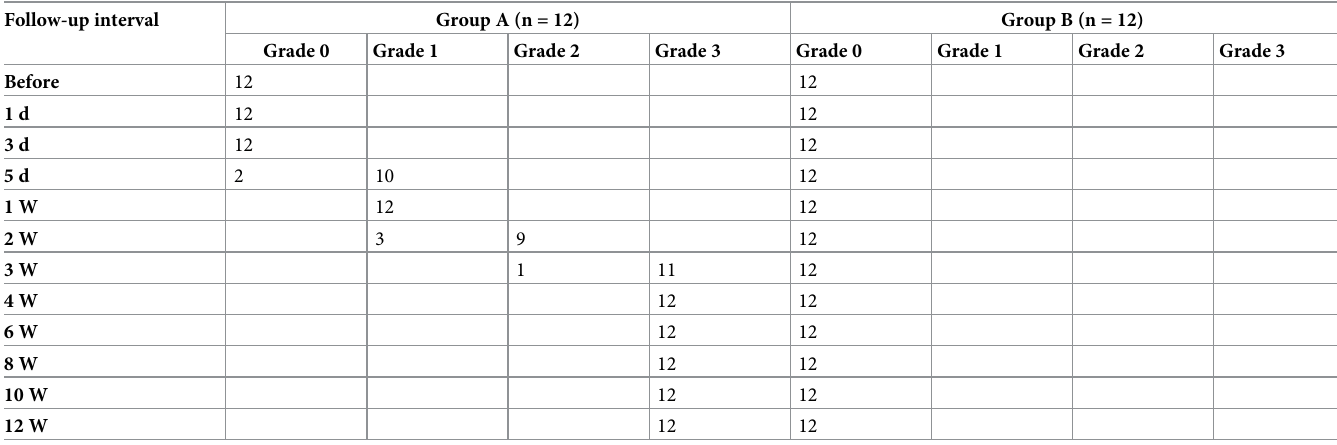
12 weeks after surgery (Tables 2 and 3, Figs 1, 2 and 3). K trans values increased significantly during the periods from pre-operation to1 day after surgery ( P = 0.029), from 1 day after sur- gery to 3 days after surgery ( P < 0.001), from 3 days after surgery to 5 days after surgery ( P < 0.001), from 5 days after surgery to 1 week after surgery ( P < 0.001), from 1 week after surgery to 2 weeks after surgery ( P < 0.001), from 2 weeks after surgery to 4 weeks after sur- gery ( P < 0.001). V values increased significantly during the periods from pre-operation to 1 p day after surgery ( P < 0.001), from 1 day after surgery to 3 days after surgery ( P = 0.001), from 3 days after surgery to 1 week after surgery ( P < 0.001), from 1 week after surgery to 2 weeks after surgery ( P = 0.007). From 2 weeks after surgery to 4 weeks after surgery ( P = 0.001) How- ever, K values show no significant difference between the irreversible neurotmesis group and ep the control group.